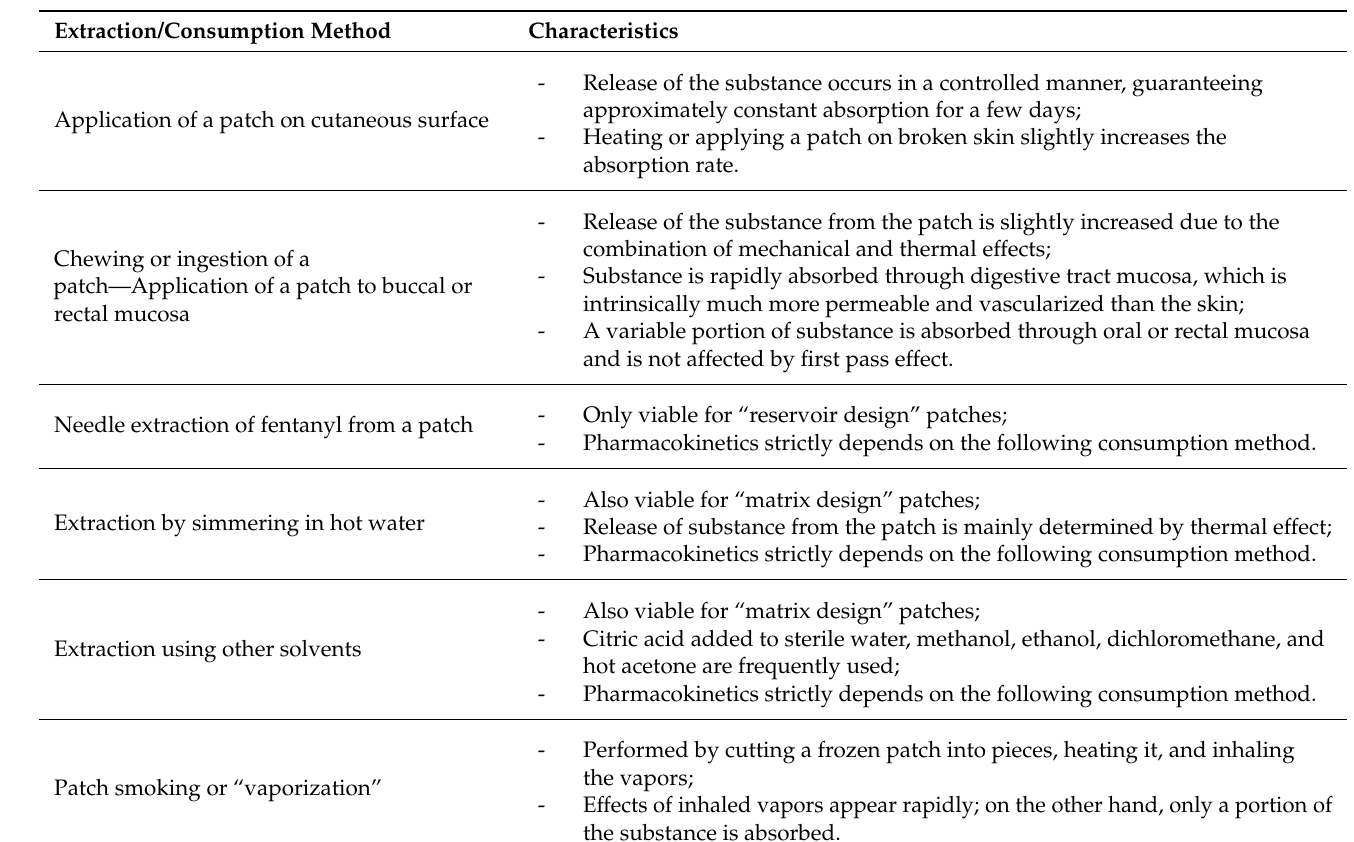
Table 3. Different methods of extraction/consumption of fentanyl contained in an adhesive